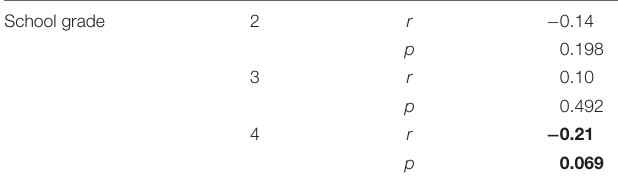
TABLE 5 | Partial correlation matrix between reading comprehension and reading speed in each grade level, controlling for word recognition ability. School